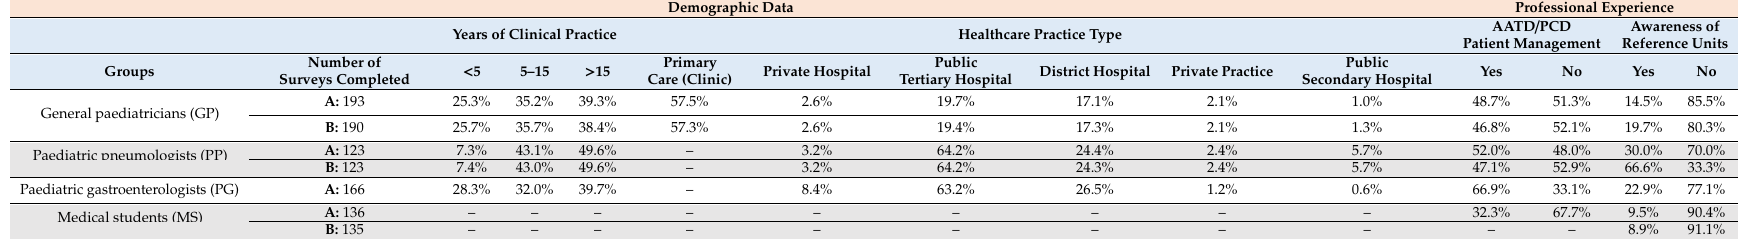
Table 1. Demographic characteristics and professional experience of the individuals participating in the alpha-1 antitrypsin deficiency / primary ciliary dyskinesia (AATD / PCD) knowledge study.